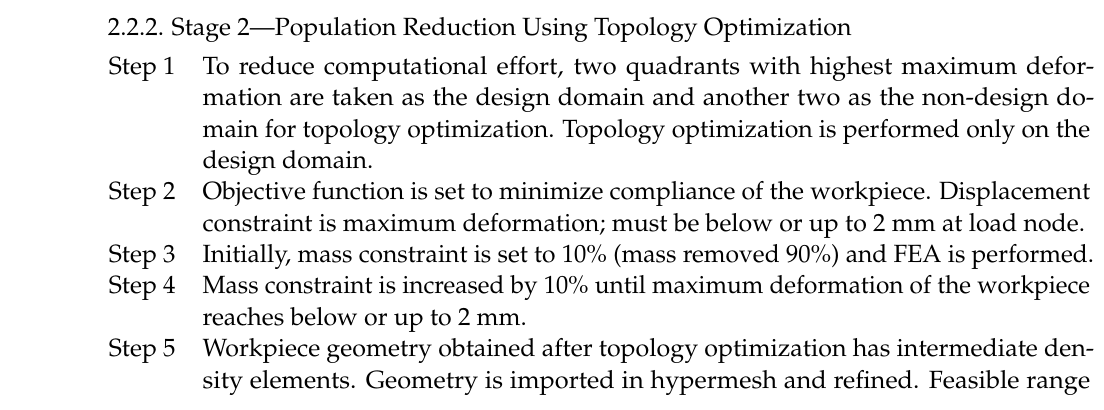
Figure 2. Stage 1 flowchart for finding initial number of clamps by using maximum deformation point data.